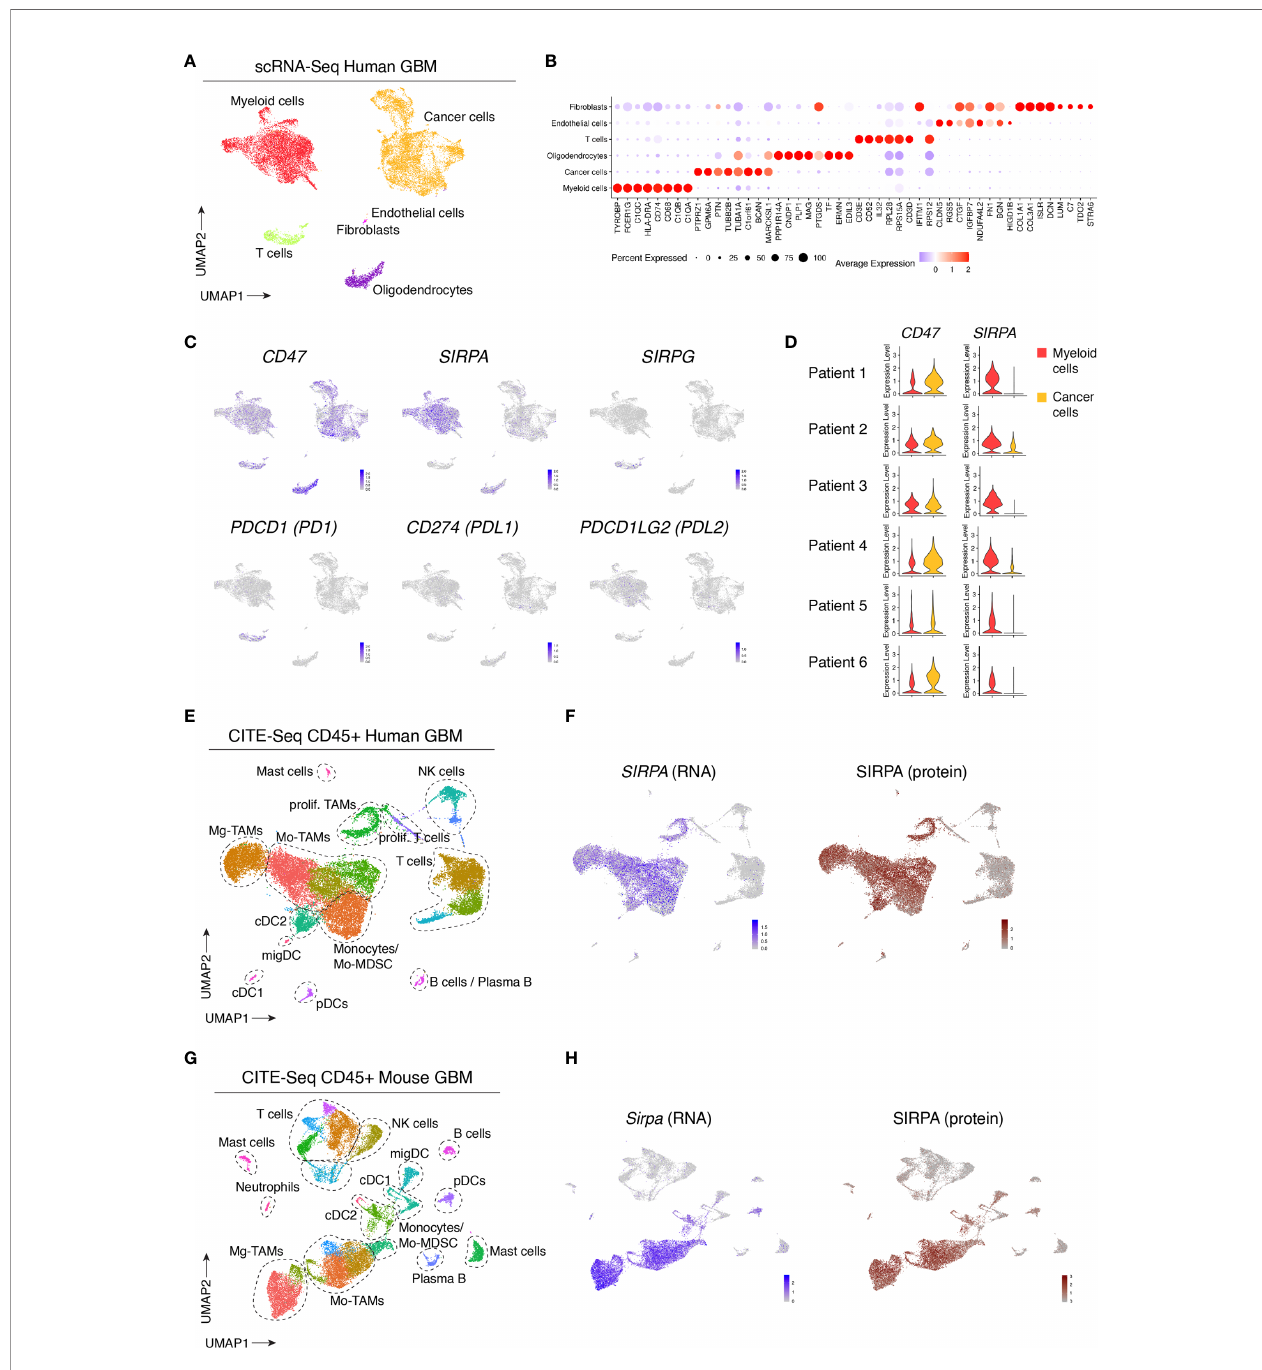
FIGURE 1 | Single-cell pro fi ling of human and mouse GBM tumors reveals consistent SIRP a gene and protein expression in tumor-associated myeloid cells. (A) UMAP plot of 20033 cells isolated from n = 6 GBM tumors, visualizing the identi fi ed cell populations. (B) Dot plot, corresponding to the UMAP plot shown in (A) , visualizing the expression of key signature genes of the indicated cell populations. The dot size relates to the percentage of cells expressing the gene, while the color relates to its scaled average expression. (C) UMAP plots showing expression of the indicated genes. The color code and range of normalized counts are shown at the lower right on each plot. (D) Violin plots showing the expression of CD47 and SIRPA on myeloid cells (red) and cancer cells (yellow) for each individual patient. (E) Gene expression-based UMAP plot of 25113 CD45 + cells, isolated from n = 3 human GBM tumors and pro fi led with CITE-seq. (F) Feature plot showing SIRPA gene expression (blue) and SIRPA protein expression (brown) based on CITE-seq antibody staining (Antibody-Derived Tag or ADT signals), corresponding to the dataset shown in (E) . (G) Gene expression-based UMAP plot of 23926 CD45 + cells isolated from orthotopic mouse GL261 tumors (n = 2 groups) and pro fi le with CITE-seq. (H) Feature plot showing Sirpa gene expression (blue) and SIRPA protein expression (brown) in GL261 tumors based on CITE-seq antibody staining, corresponding to the dataset shown in (G)